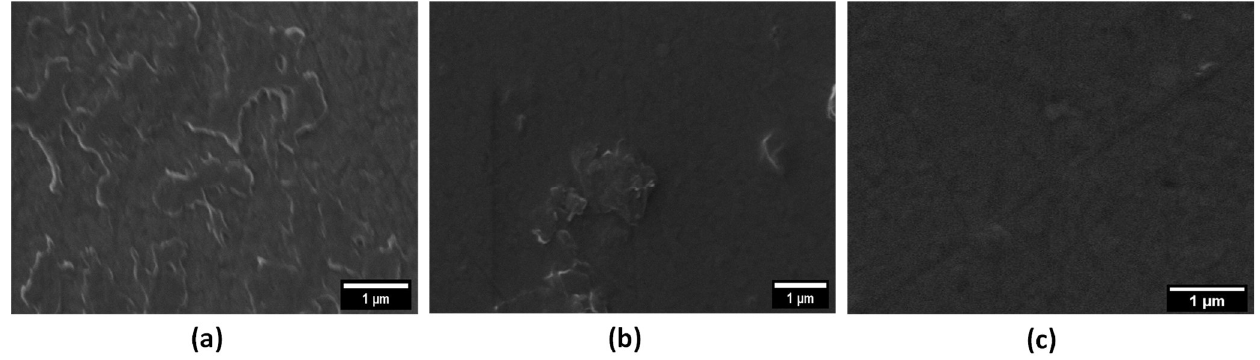
Figure 2. ( a ) SEM image of GO-PEDOT; ( b ) SEM image of GGO-PEDOT; ( c ) SEM image of AAGO- PEDOT.